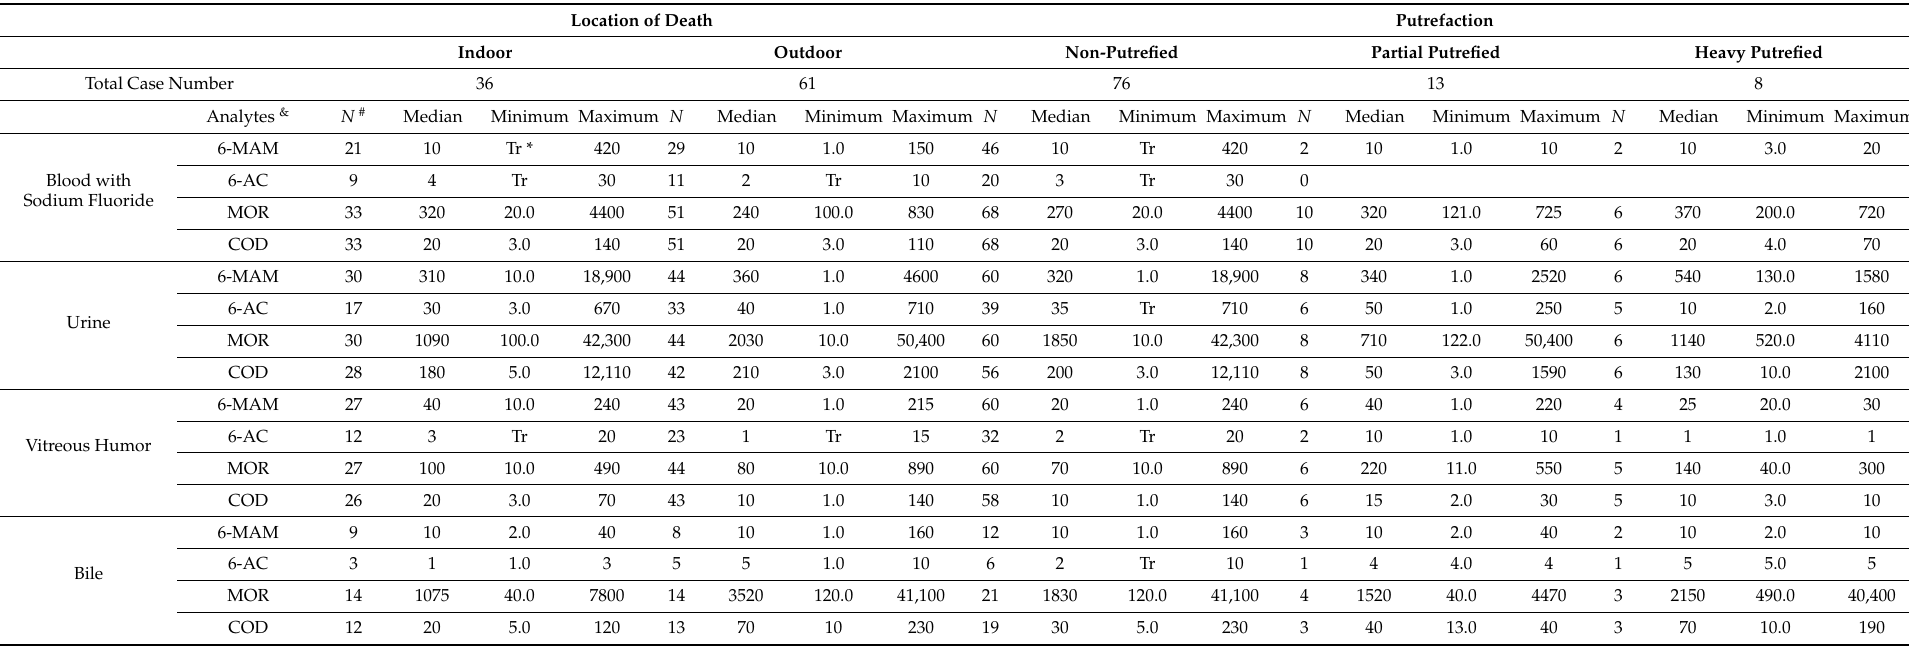
Table 6. Location of deaths and state of deceased body at autopsy in the 97 heroin-related fatalities cases in Jeddah, Saudi Arabia between 2008–2018. Location of Death